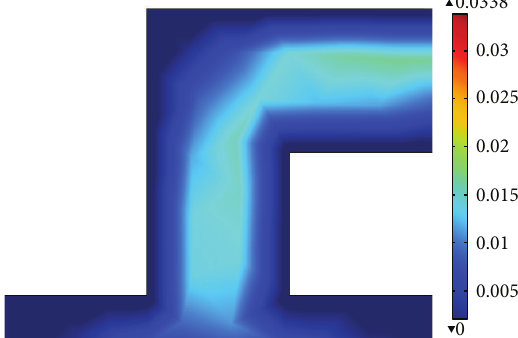
Figure 8: Schematic presentation of velocity flow at sharp corner of microfluidic